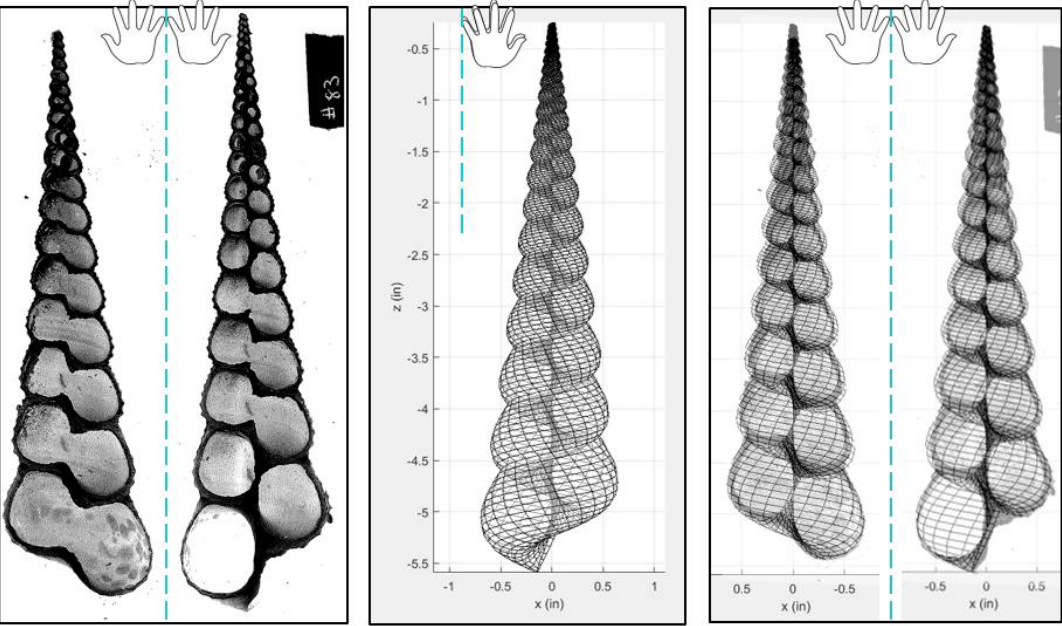
Figure 5. Cross-sectional scan of shell halves ( left ); MATLAB generated the model using the specimen’s parameters ( center ); and digital overlays of each half ( right ). The hand symbols represent the opening of the shell into two halves.